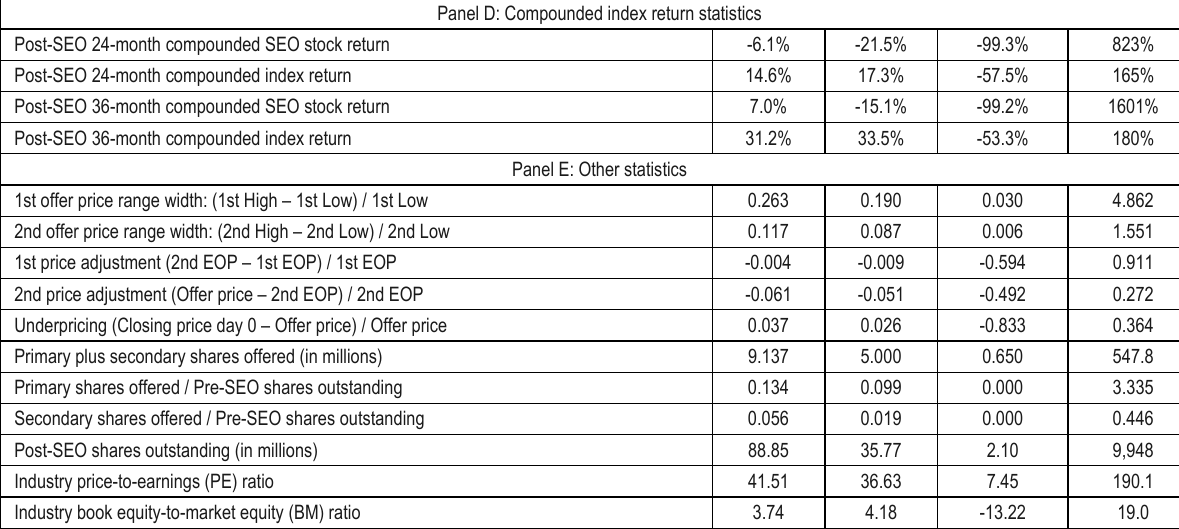
Table 1 (cont.). Descriptive statistics for 674